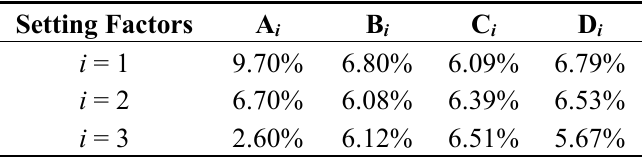
Table 10. THD for all levels of all factors.